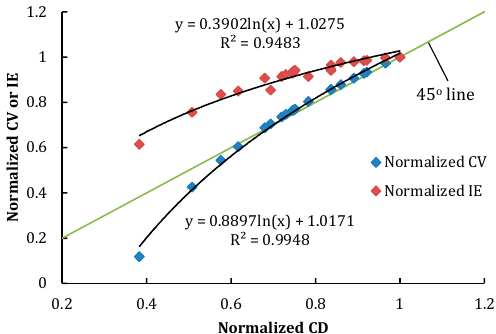
Figure 2. Variation of the normalized CV and information entropy (IE) vs. the normalized CD.